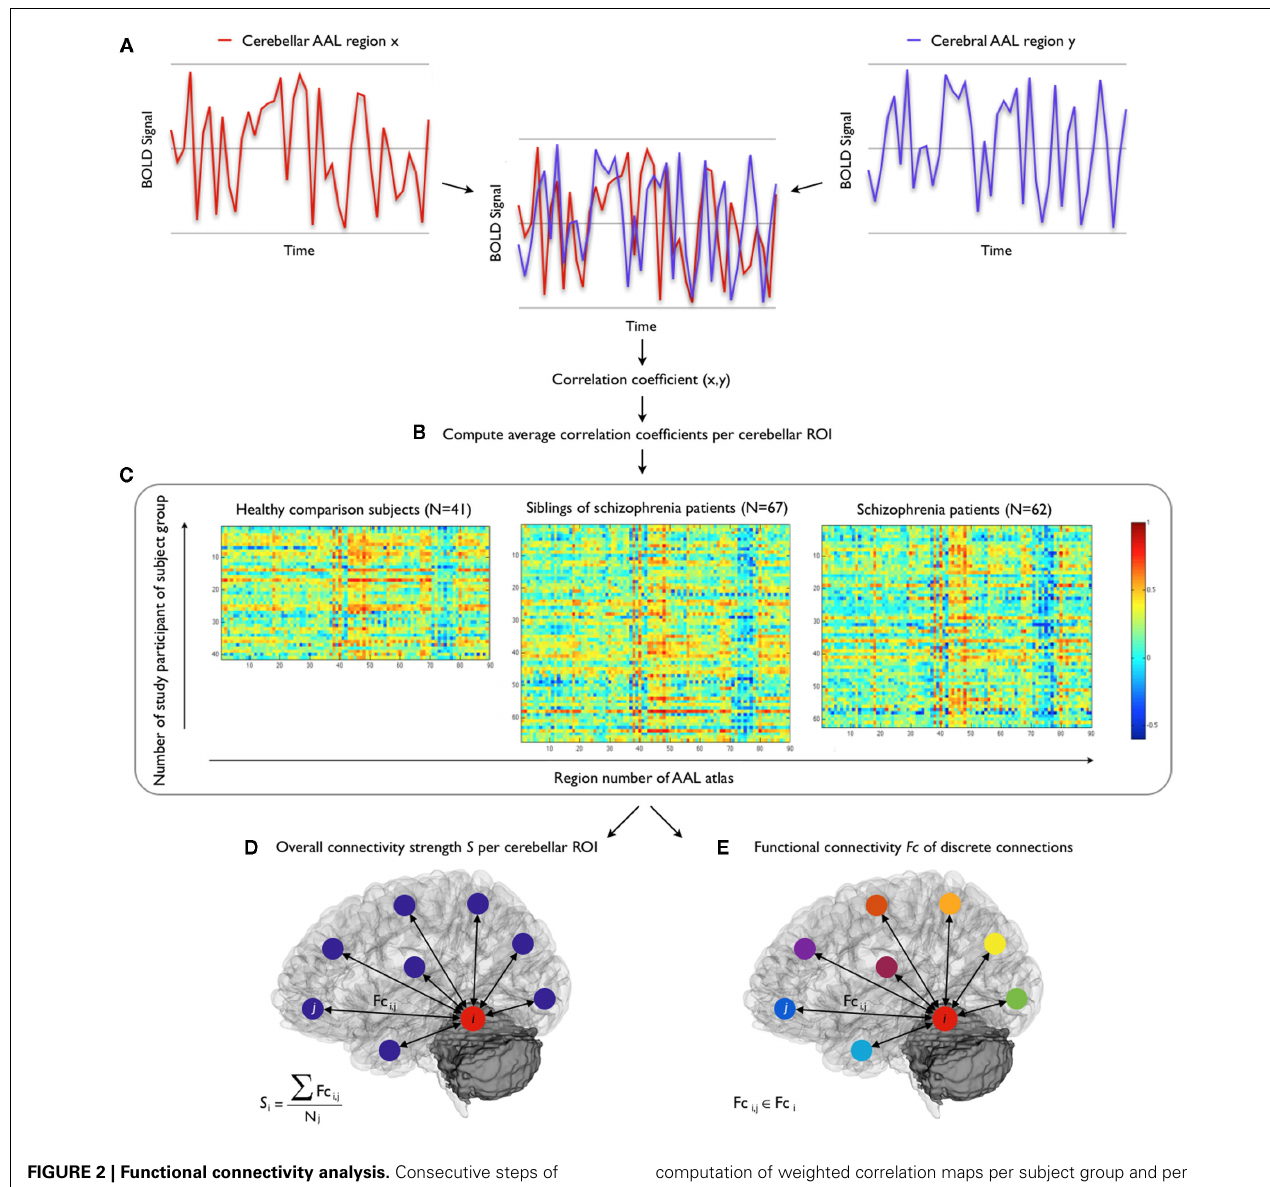
FIGURE 2 | Functional connectivity analysis. Consecutive steps of the functional connectivity analysis. (A) Computation of correlation between cerebellar and cerebral resting-state fMRI time-series, (B) calculation of correlation coefficients of cerebellar ROIs, (C)